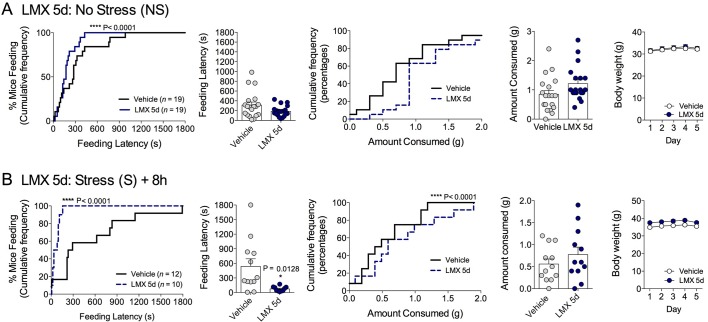
Effects of subchronic COX-2 inhibition on feeding latency in the NIH test.(A) Effects of 5 consecutive daily administrations of Lumiracoxib (LMX) on feeding latency and food consumption in the NIH test, and body weight, in control non-stressed mice. (B) Effects of 5 consecutive daily administrations of LMX on feeding latency and food consumption in the NIH test 8 hr after foot-shock exposure. *p<0.05 by two-tailed unpaired t-test. For cumulative distribution curves, ****p<0.0001 by K-S test.